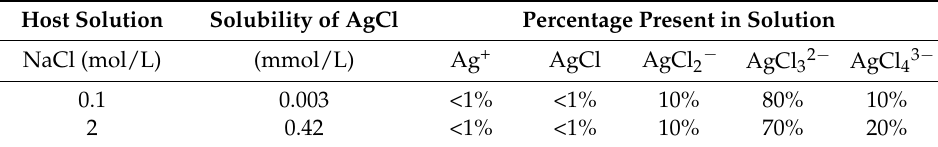
Table 4. Solubility of AgCl in NaCl solutions at 25 ◦ C [21].